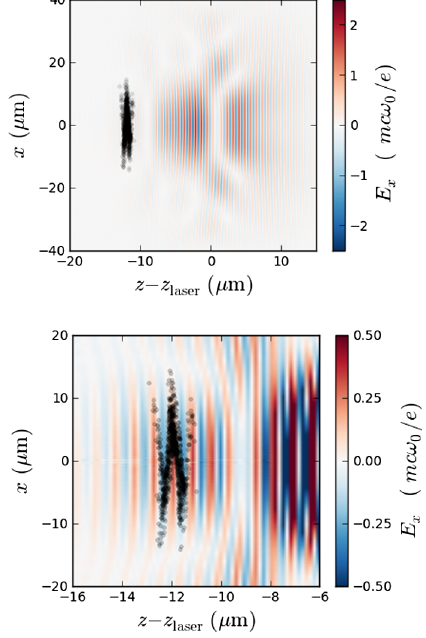
FIG. 6. Top panel: Snapshot of the simulation at z ¼ 550 μ m (i.e., inside the drift space), showing the laser pulse (red and blue) and the trailing electron bunch (black dots). Bottom panel: Zoom on the electron bunch. (Notice that the electric field E x has also been